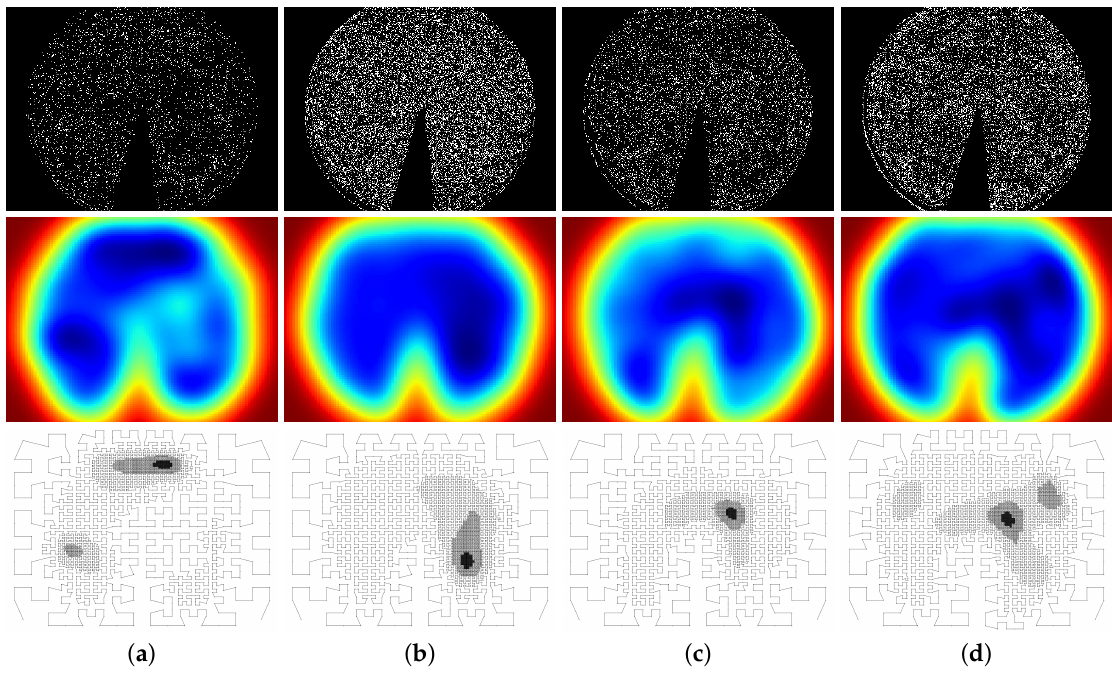
Figure 4. MHHs ( top ), Kernel Density Estimation (KDE) implicit functions ( middle ), and foveal models ( bottom ) generated for the ( a ) 010, ( b ) 0110, ( c ) 01110, and ( d ) 011110 patterns considering the 2012